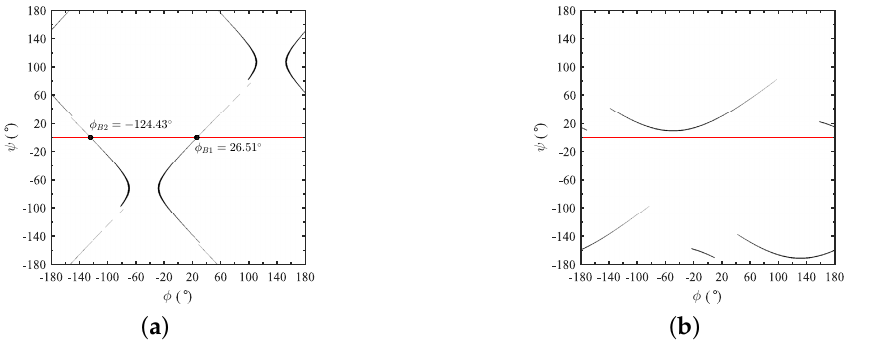
Figure 7. ( a ) Horizontal hyperbola of the filter with Ω Bk TZs and ( b ) vertical hyperbola of the filter with Ω Ck TZs. The black trace are those combinations of φ , ψ that yields | J N + 1 | = 1 ± 0.001. The red line across the φ axis is at ψ = 0.